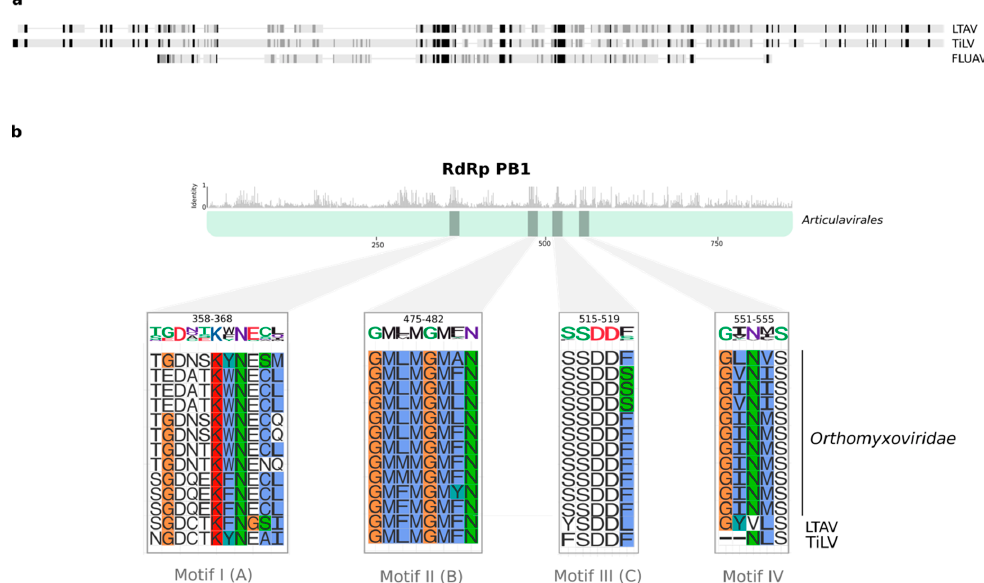
Figure 2. Conserved motifs in the RdRp subunit PB1 from the order Articulavirales . ( a ) Comparison of the Lauta virus RdRp sequence with the full-length PB1 sequence of TiLV and FLUAV. The gradient from black to light grey indicates the level of sequence similarity in the alignment. Highly conserved positions are shown in black. ( b ) Top panel shows the mean pairwise identity over all pairs in the column across the multiple sequence alignment among members of the order Articulavirales . Sequence motifs are shown with grey bars. The bottom panel depicts a magnified view of individual motifs. Letters in parenthesis denote the A–G RdRp motif nomenclature. The original amino acid residue position and standard logos are displayed in the top of each motif; the size of each character represents the level of sequence conservation. Amino acid residues in the alignment are colored according to the Clustal coloring scheme. Table 2. Percentage of identical residues among members of the order Articulavirales and Lauta virus .